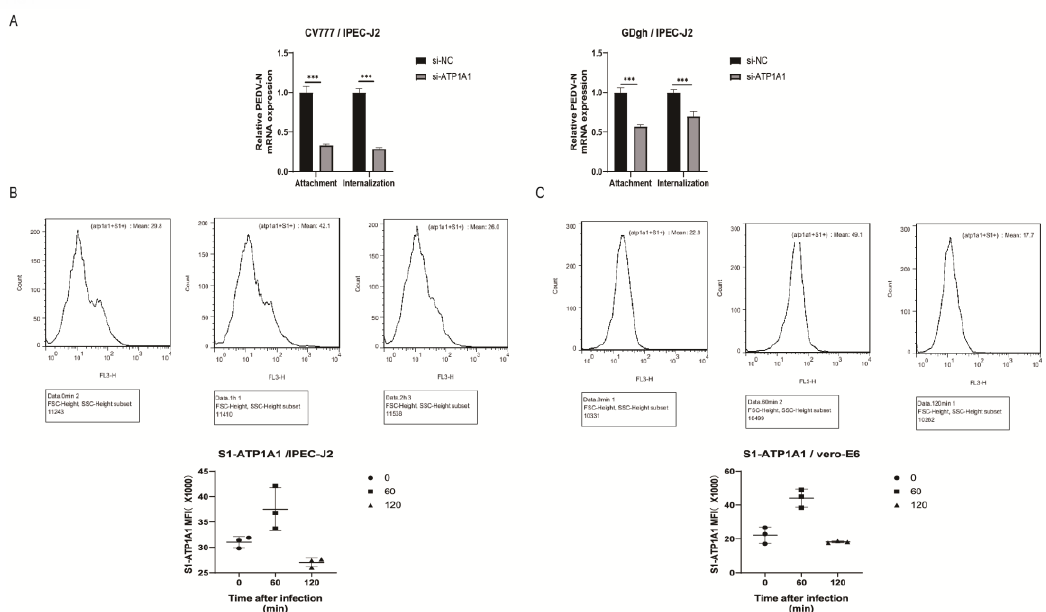
Figure 7. Knockdown of ATP1A1 affects the attachment of PEDV. ( A ) Knockdown of ATP1A1 significantly suppresses attached PEDV. Transfection with siRNAs against ATP1A1 and siRNA-NC for 24 h. In the attachment assay, PEDV at 1.0 MOI infected target cells at 4 ◦ C for 2 h and then cells were washed with PBS and were collected to detect viral RNA abundance. In the internalization assay, PEDV at 1.0 MOI infected target cells at 4 ◦ C for 2 h and then cells were washed with PBS and transferred to 37 ◦ C for 1 h incubation to complete virus internalization. After washing the cells with PBS, the cells were treated sequentially with 0.05% trypsin and 0.5 mg/mL proteinase K to remove the uninternalized virus particles, and the cells were collected for viral RNA detection. Data represent means ± SD from three independent experiments. ***, p < 0.001. ( B , C ) S1 number of positive cells bound to ATP1A1. Incubating IPEC-J2 and Vero-E6 on ice with PEDV at 1.0 MOI for 1 h to synchronize infection, then transferring to 37 ◦ C incubator for the indicated time. Cells were collected after washing with PBS at the appropriate time points. Cells were then stained using rabbit anti-ATP1A1 mAb and mouse anti-S1 mAb, followed by CoraLite488-conjugated Goat Anti-Rabbit IgG and CoraLite594-conjugated Goat Anti-Mouse IgG. Data analysis using flow cytometry. In addition, we used flow cytometry to quantify the interaction between ATP1A1